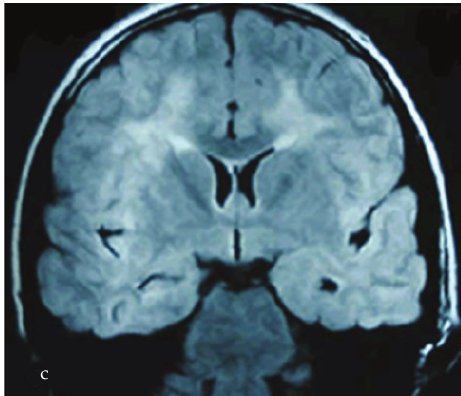
Figure 2: Coronal view of the brain.